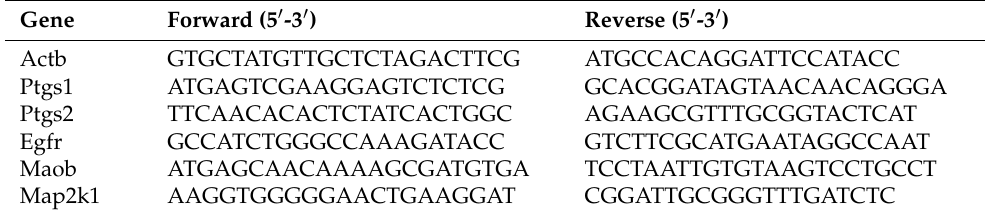
Table 3. Primers used in RT-qPCR.